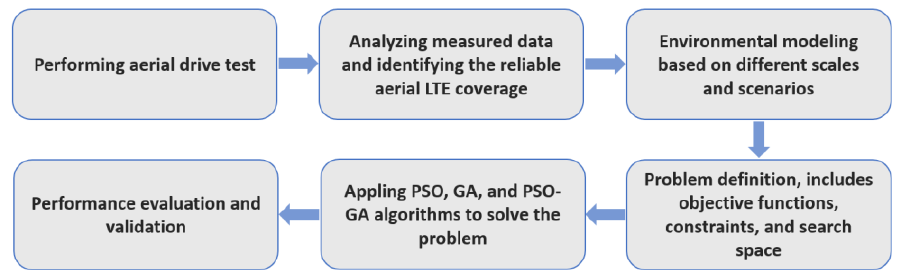
Figure 1. Schematic diagram of the considered path planning problem.